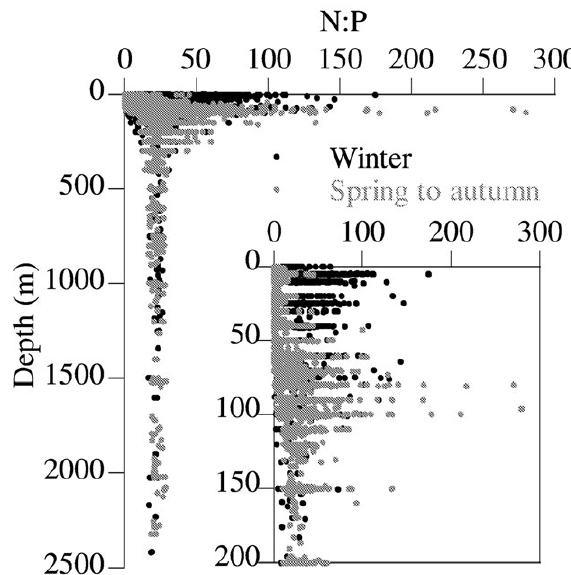
Fig. 10. – Depth profile of N:P for the Catalan Sea. Data for winter mixing are shown with black circles, and data for stratified water columns (spring-autumn) are shown with grey